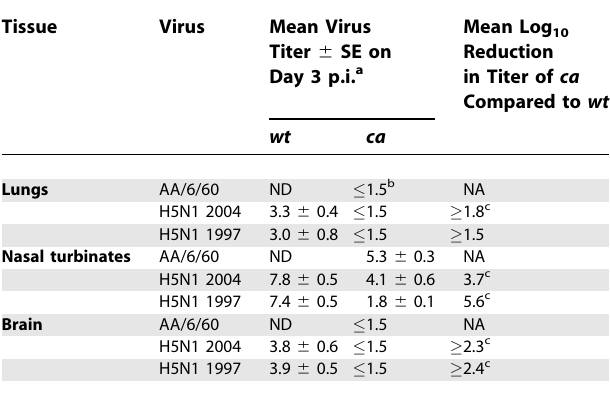
Table 4. The H5N1 ca Viruses Are Attenuated in Ferrets Tissue Virus